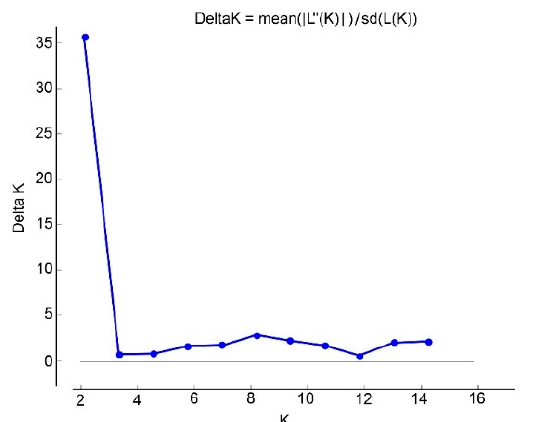
Figure 4. Results from Structure Harvester analysis reveal the most likely value of K based on STRUCTURE results.